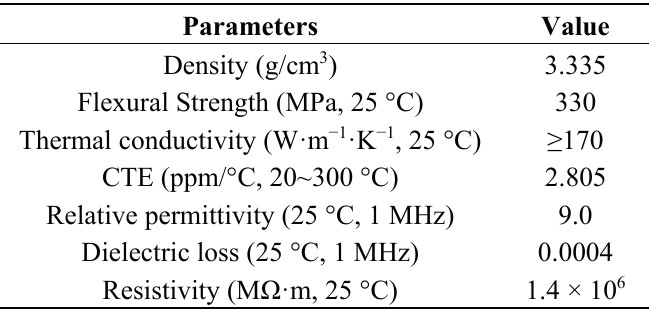
Figure 4. Fabrication process of the resonator. ( a ) Surface pre-process; ( b ) Screen-print circuit: Top electrode and inductance coil and bottom electrode; ( c ) Cure the conductive paste; ( d ) Examine. Table 2. Characteristic parameters of AlN